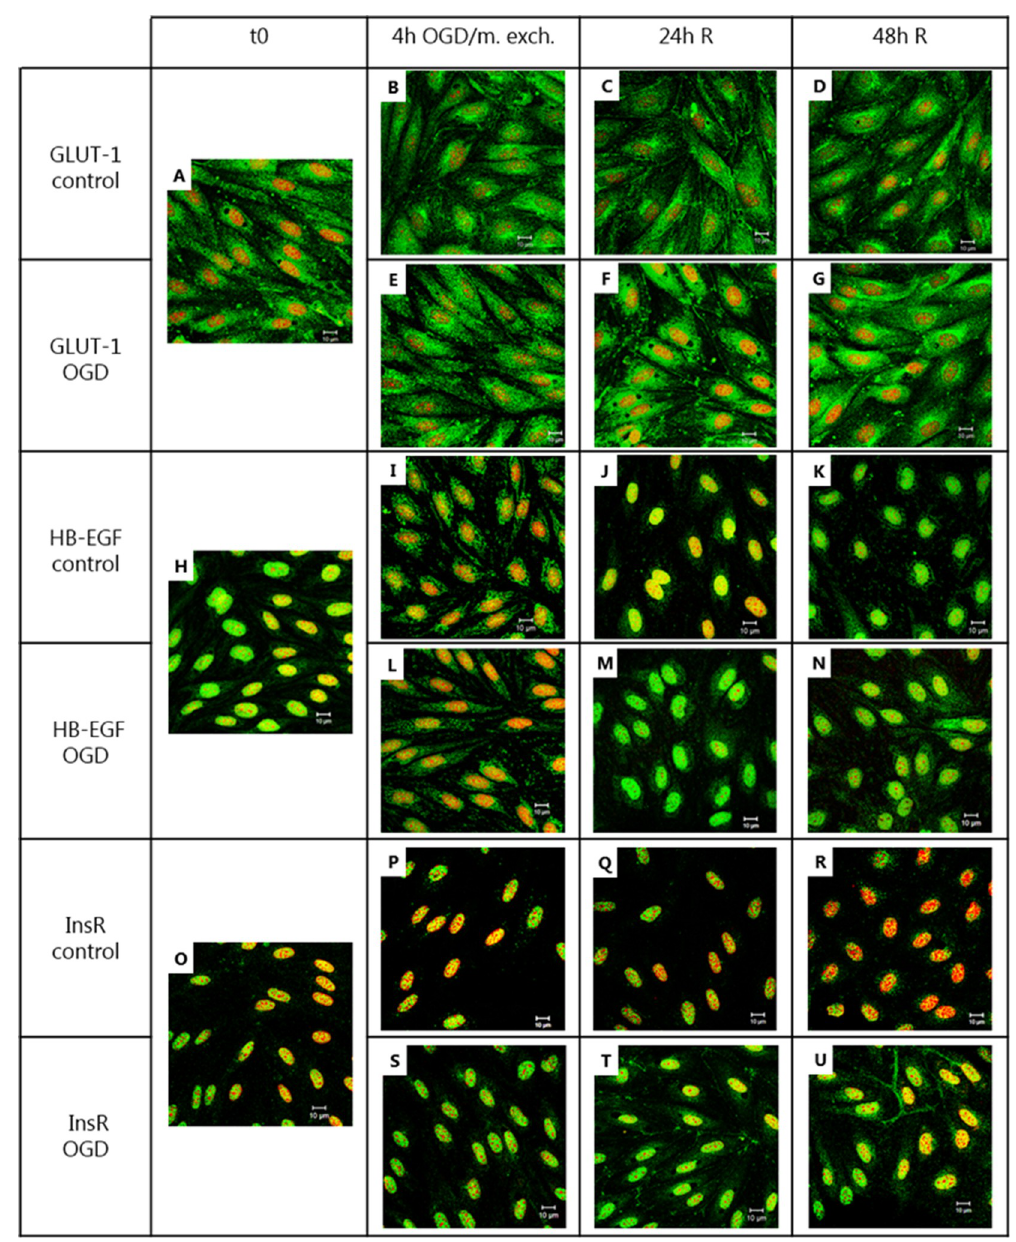
Fig 7. Immunocytochemistry analysis of GLUT-1, HB-EGF and InsR protein localization before, during and after oxygen-glucose deprivation (OGD) and medium exchange treatment. Endothelial cells co-cultured with astrocytes were subjected to OGD for 4 h or to medium exchange, followed by 24/48 h of reperfusion. For each condition, a filter insert was collected, fixed and stained with an antibody against GLUT-1 (A-G), HB-EGF (H-N) or InsR (O-U) (green), and counterstained with propidium iodide for visualizing the cell nuclei (red). Bars = 10 μ m. N = 1, n = 3.